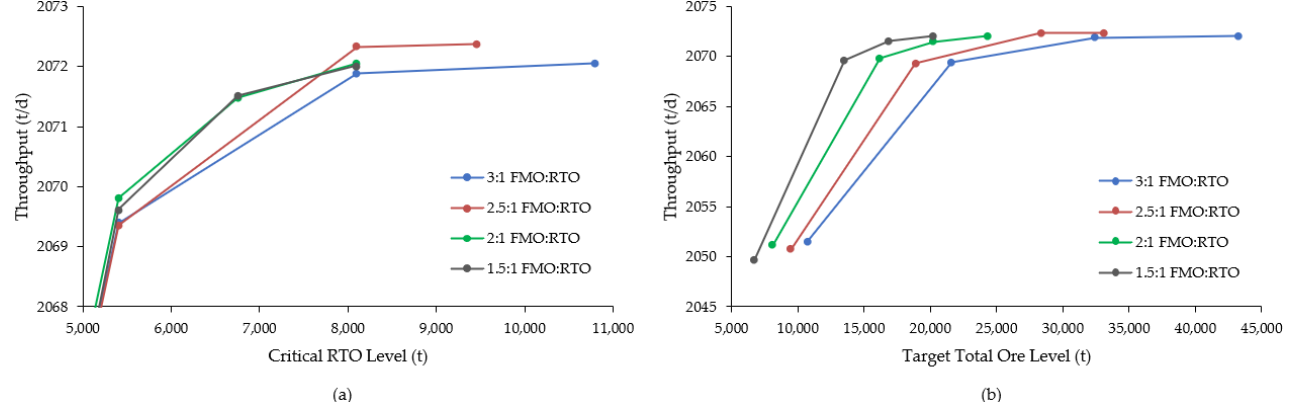
Figure 9. Plots of throughput rates (t/d) versus ( a ) critical RTO level and ( b ) target total ore level for a variety of simulated ore type ratios over 100 statistical replications.